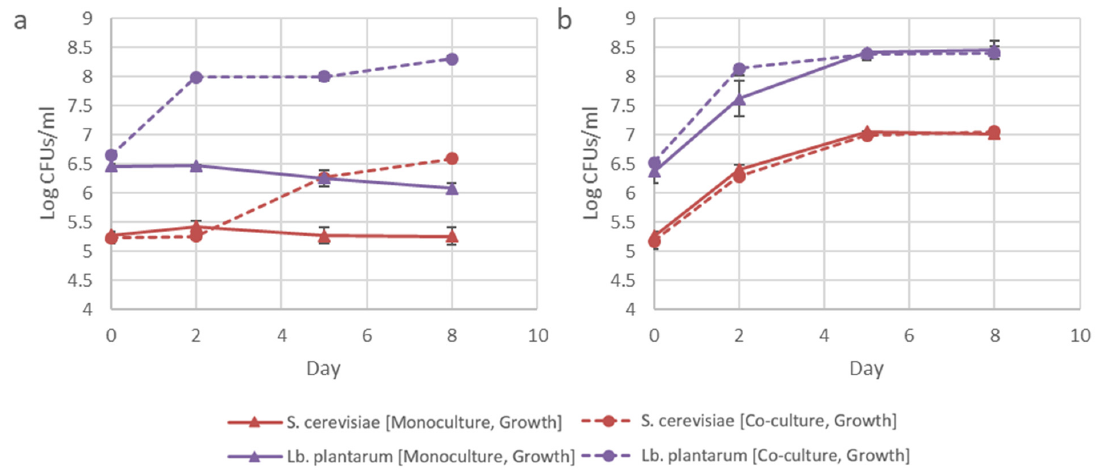
Figure 4. Influence of inoculation dosage on log CFUs / mL for S. cerevisiae BY4742 ∆ thi4 and Lb. plantarum IWBT B038 under mono- and co-culture conditions for Lys-Ile ( a) and control ( b ) treatments. Data shown are means of triplicates, with error bars representing standard deviation.